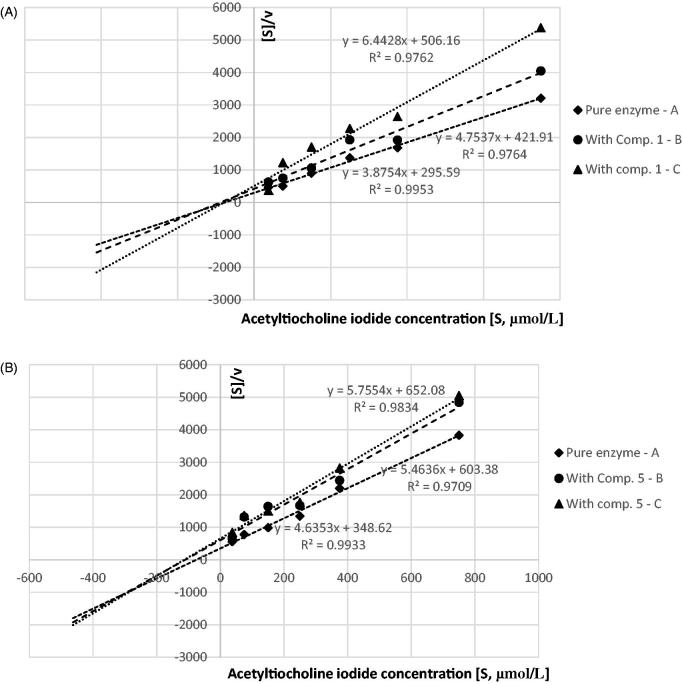
Determination of kinetic parameters of AChE enzymatic reactions. Hanes–Woolf plots we used to calculate the Michaelis constant (Km) and maximal velocity (Vmax). (A) AChE and compound 1 at concentration of 1055.0 µmol/L and 3166.0 µmol/L; non-competitive inhibition. (B) AChE and compound 5 at a concentration of 71.0 µmol/L and 212.0 µmol/L; mixed inhibition. Presented data constitute the results of one exemplary experiment conducted in duplicates. The results of kinetic studies conducted in three independent experiments and calculated kinetic parameters are enclosed in Table 2.